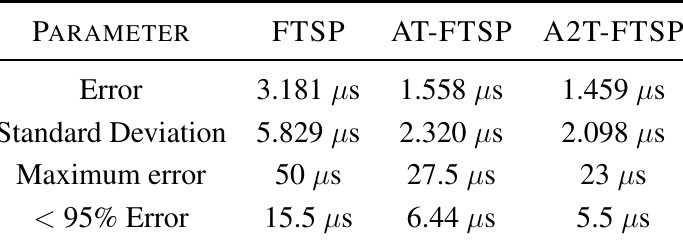
Table 3. Results with temperature variation: 9 ◦ C– 22 ◦